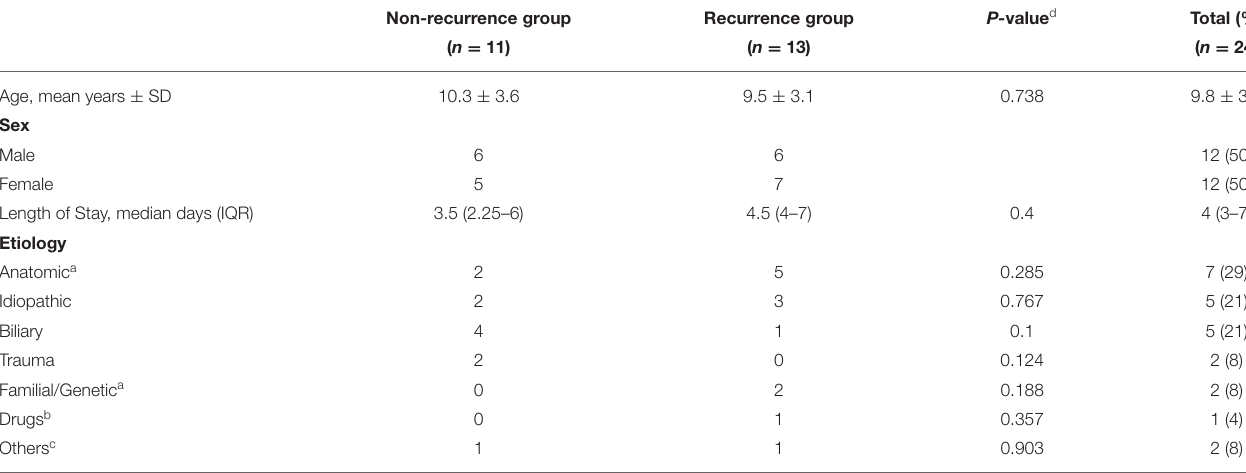
TABLE 1 | General characteristics of patients, and the causative etiology.